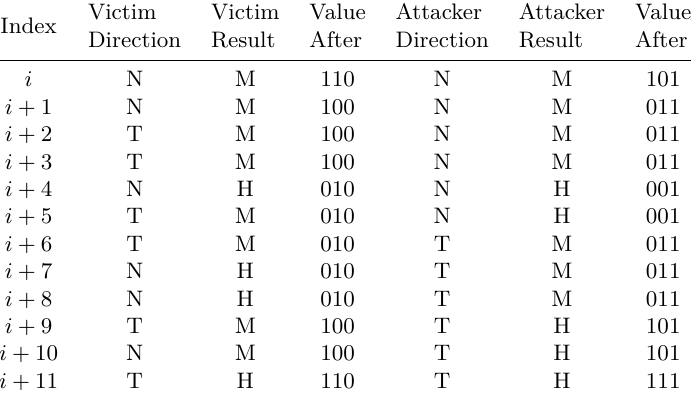
Table 3: The result of executing the attacker’s target branch with the TBDV “000,000,111,111”, in which “0” means “not taken” and “1” means “taken” (run both processes together). M – misprediction, H – hit (correct prediction), N – not taken, T – taken, Value After – the binary value of the saturating counter after executing the